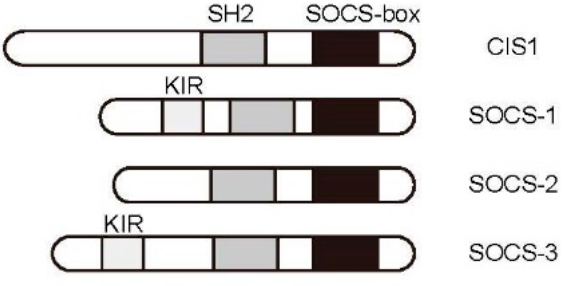
Figure 3. SOCS family proteins. SOCS members share a central SH2 domain and carboxyl terminal SOCS Box. SOCS1 and SOCS3 possess a kinase inhibitory region (KIR) that serves as a pseudo-substrate for